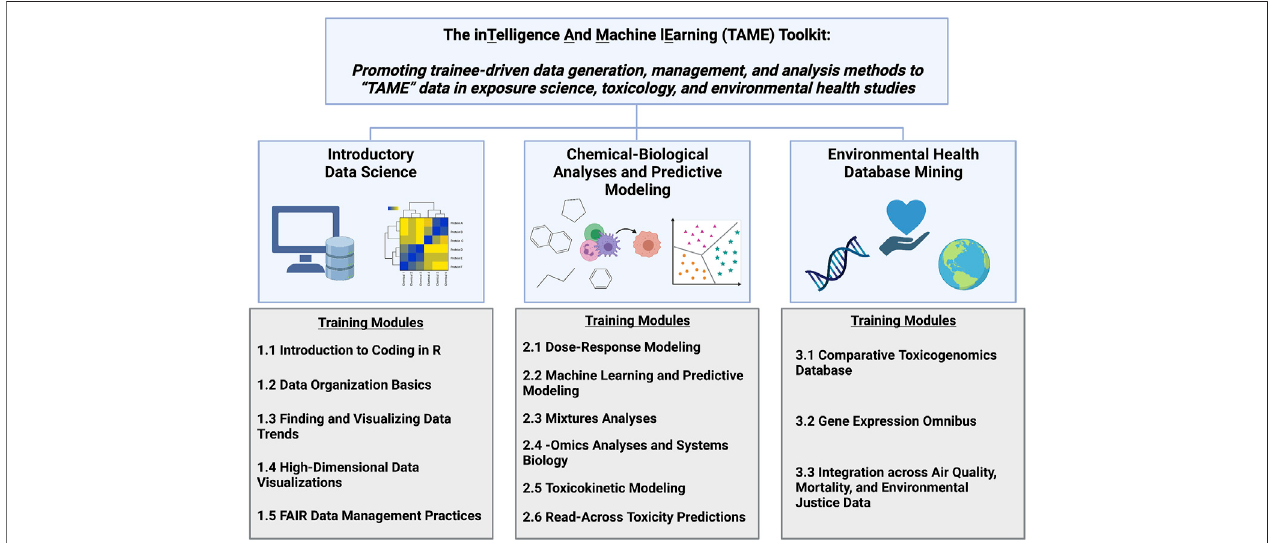
FIGURE1| OverallorganizationoftheTAMEToolkit,developedtopromotetrainee-drivendatageneration,management,andanalysismethodsto “ TAME ” datain exposure science, toxicology, and environmental health research. Individual training modules were developed in R coding language to provide applications-based training in the broad categories of data science, chemical-biological analyses and predictive modeling, and environmental health database mining.